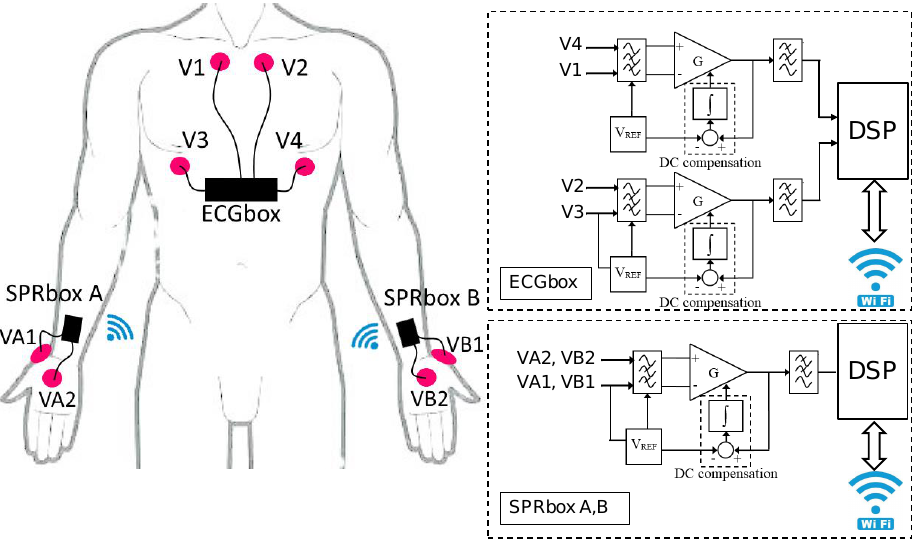
Figure 1. ( Left ) scheme of sensors and electrodes positioning—the skin potential response (SPR) boxes A and B acquire electrodermal activity (EDA) signals on the hands and transmit the data to the electrocardiogram (ECG) box; the ECG box acquires signals on the chest and sends data to a laptop. ( Right ) block diagram of SPR boxes and ECG